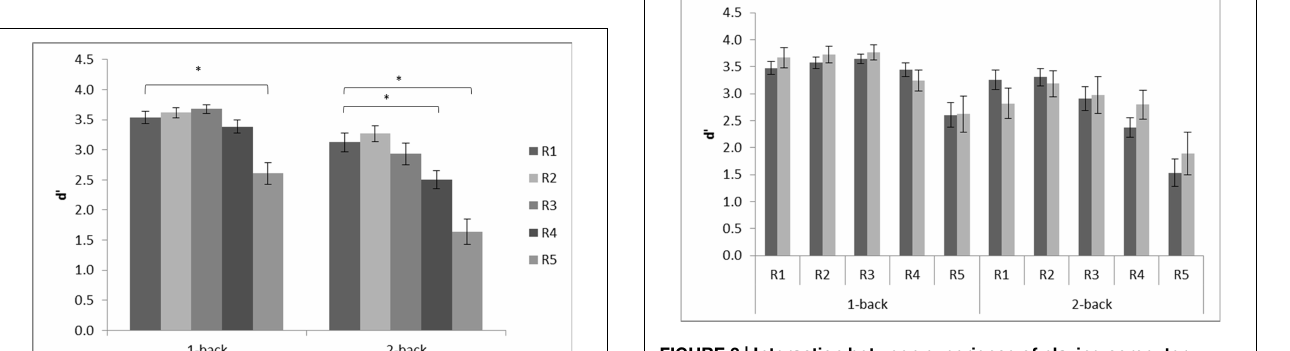
FIGURE 3 | Interaction between experience of playing computer games and performance on the n -back working memory task. R1 (720 × 480 pixels); R2 (180 × 120 pixels); R3 (90 × 60 pixels); R4 (24 × 16 pixels); R5 (12 × 8 pixels). Dark bars show mean performance for participants who did not play computer games ( n = 14) and light bars for those who did ( n = 6). Error bars show standard